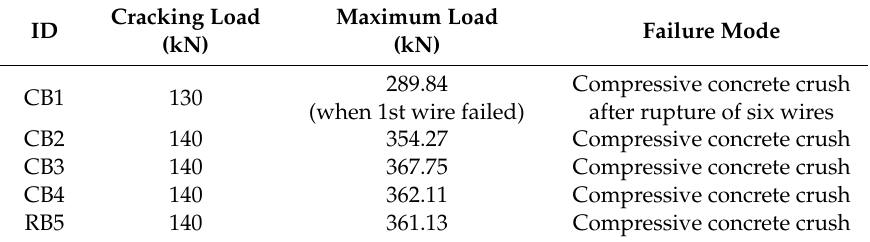
Figure 5. Load-displacement behaviors from test results. Table 3. Test results of PC beam specimens.